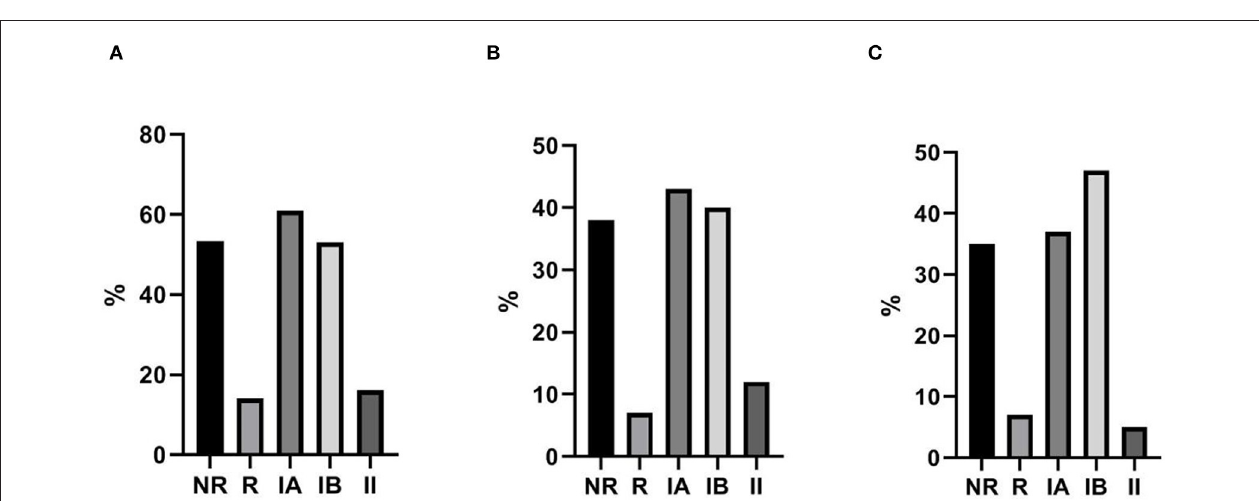
FIGURE 6 | Non-infective CVID-related complications. Percentage of bronchiectasis (A) , autoimmunity (B) and enteropathy (C) in CVID patients grouped as IgA-NR, IgA-R, and IA, IB and II according to Freiburg